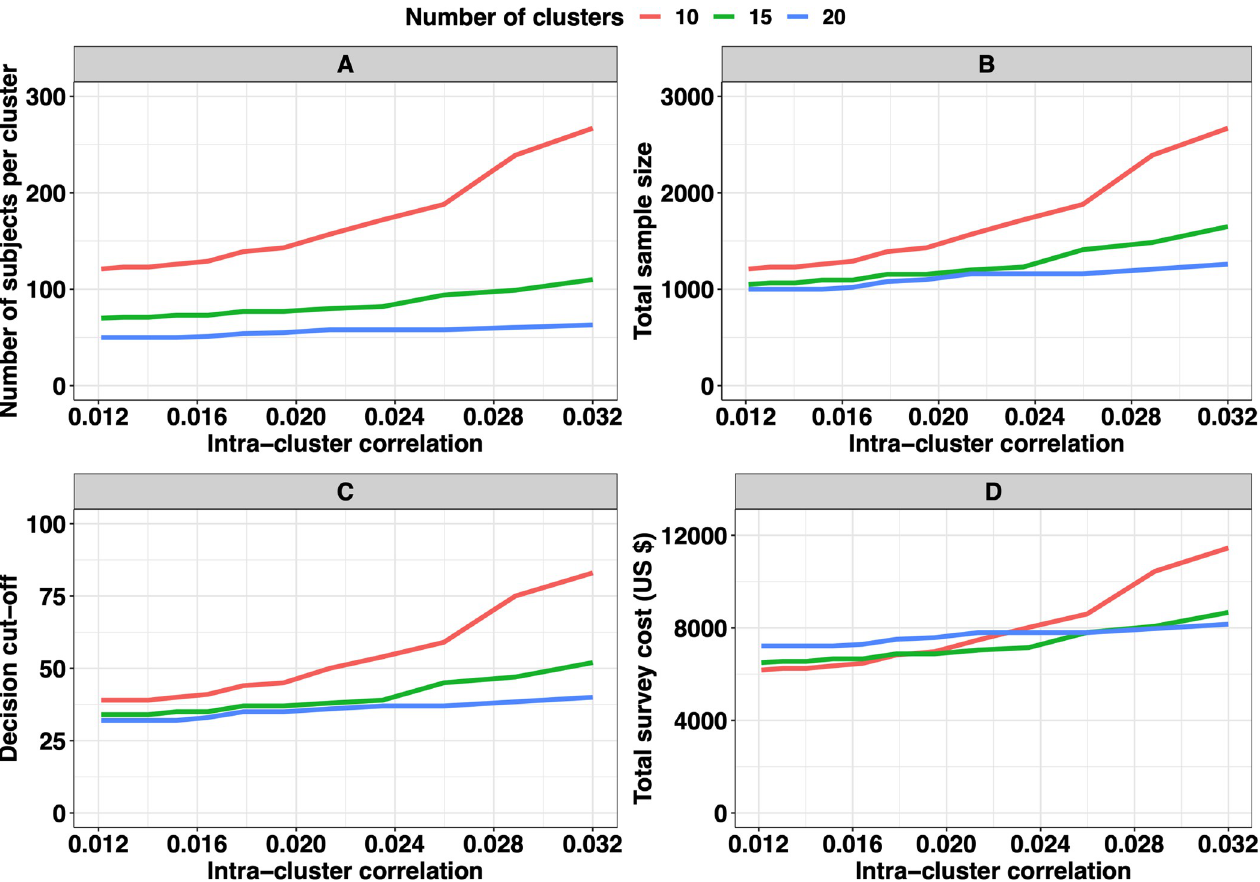
Fig 7. Impact of geographical variation in prevalence between clusters on program decision-making. This figure illustrates the impact of the geographical variation in prevalence (expressed as intra-cluster correlation, which ranged from 0.012 to 0.032) on the number of subjects per cluster ( n ; Panel A ), the total sub number of subjects sampled across n clust ( n tot ; Panel B ), the corresponding decision cut-off c ( Panel C ), and the associated total survey costs ( C tot ; Panel D ) required for adequate program decision-making ( E = 25 % and E = 5 %) around a 2% program prevalence threshold. In this figure, the sensitivity overtreat undertreat and specificity were set at 80 % and 98 %, respectively. The limits of the grey zone at 1% and 3%. All graphs are based on the same set of 10,000 Monte Carlo